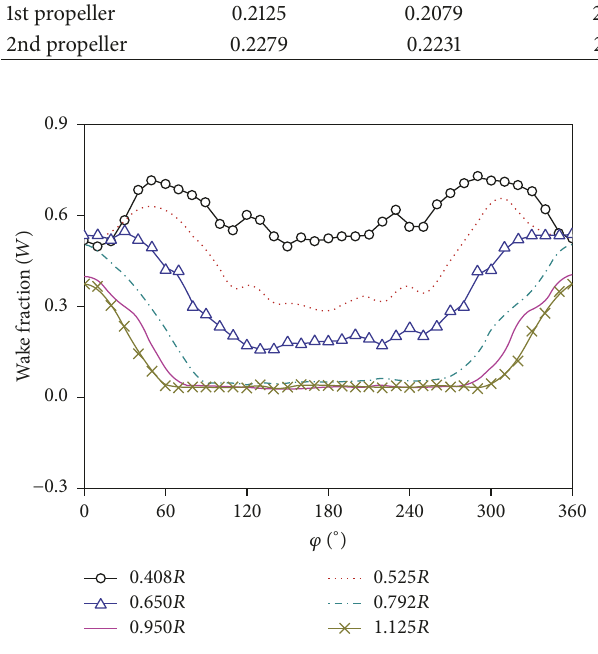
Figure 4: Simulated axial wake contours.